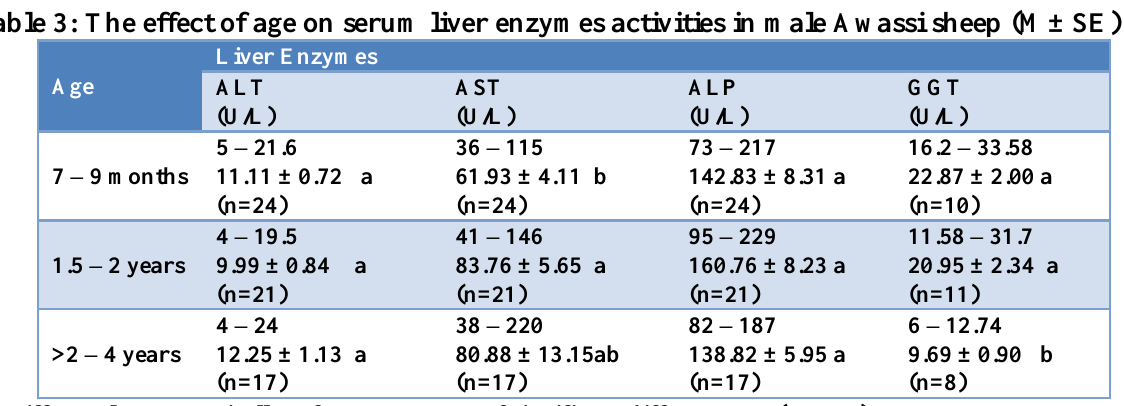
Different letters vertically refers to presence of significant differences at (P<0.05). Table, 4: Serum liver enzymes activities according to physiologic status in Awassi sheep (M±SE) Groups